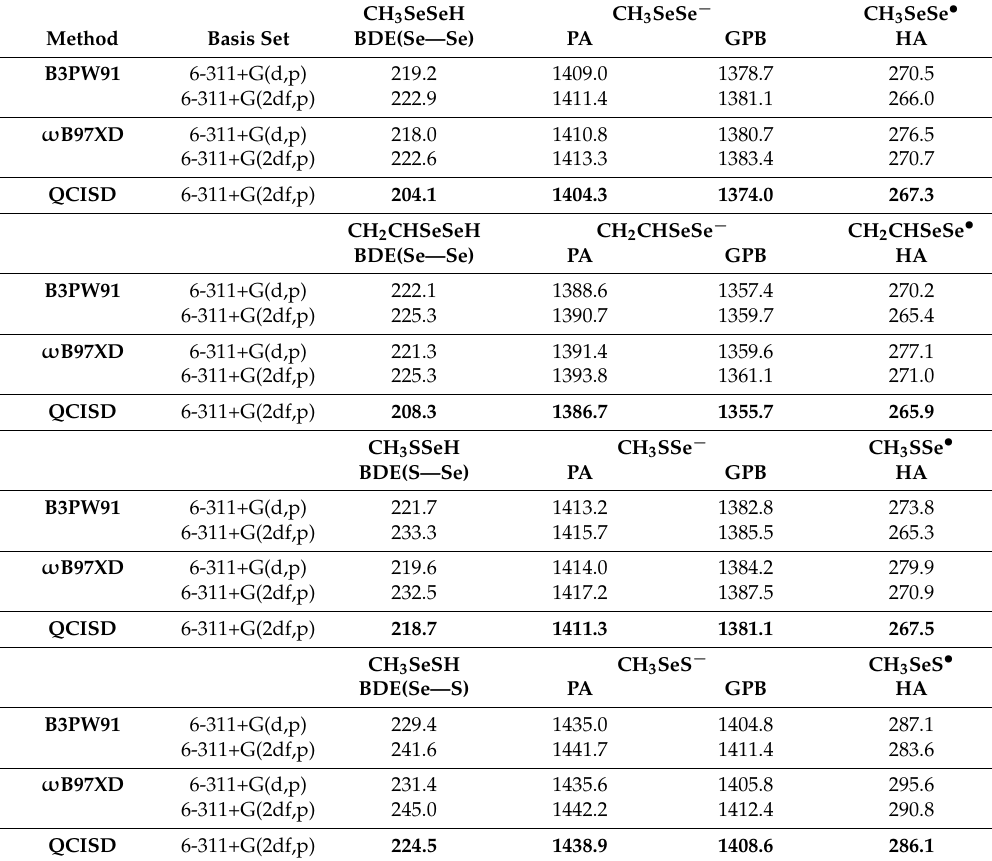
Table 6. Calculated homolytic Se − Se bond dissociation enthalpies (BDE) of RSeSeH, proton affinity (PA) and gas-phase basicities (GPB) of RSeSe − , and Se − H homolytic bond dissociation enthalpies (HA) of RSeSe • (R = CH 3 , CH 2 CH). All energies in kJ mol − 1